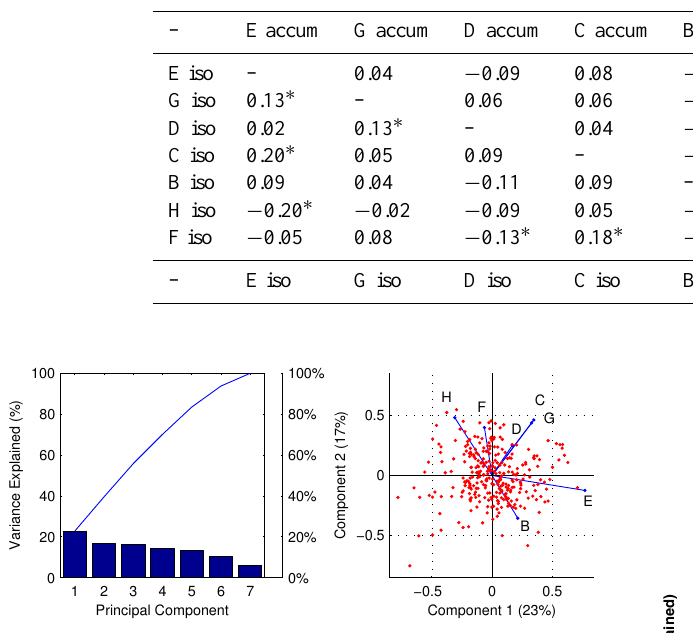
Table 4. Siple Dome correlation matrix for shallow ice core water isotope δ D time series (bottom left of matrix) and net accumulation (top right of matrix). Values with a star indicate significant Pearson’s correlation values of less than 0.05. Only similar time series should be interpreted from the table (i.e. accum with accum and iso with iso, but not accum with iso).